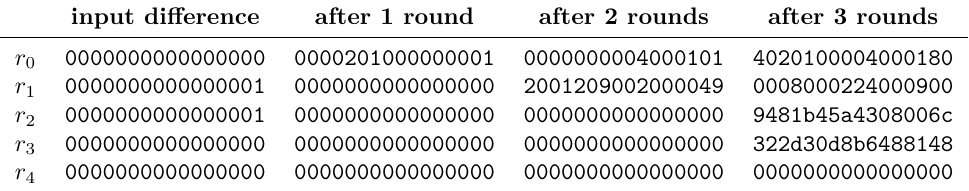
Table 14: Differential characteristic LB3.1. The probability of this characteristic is 2 − 8 . The breakdown of the probability (in − log